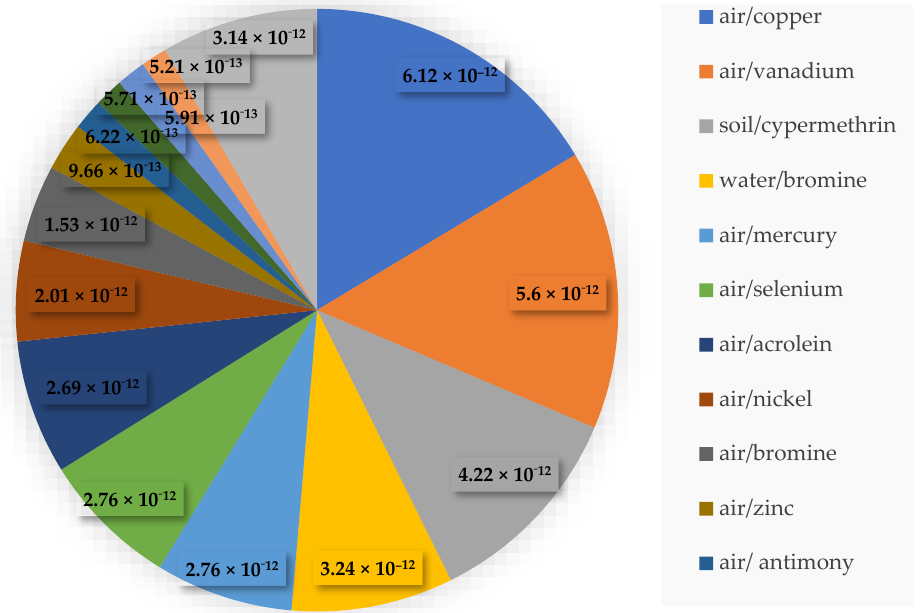
Figure 14. Terrestrial toxicity impact category for a product system of 1 kg SPF-reinforced sago starch biocomposite takeout food container (damage assessment/excluding long-term emissions/cut off 1%).